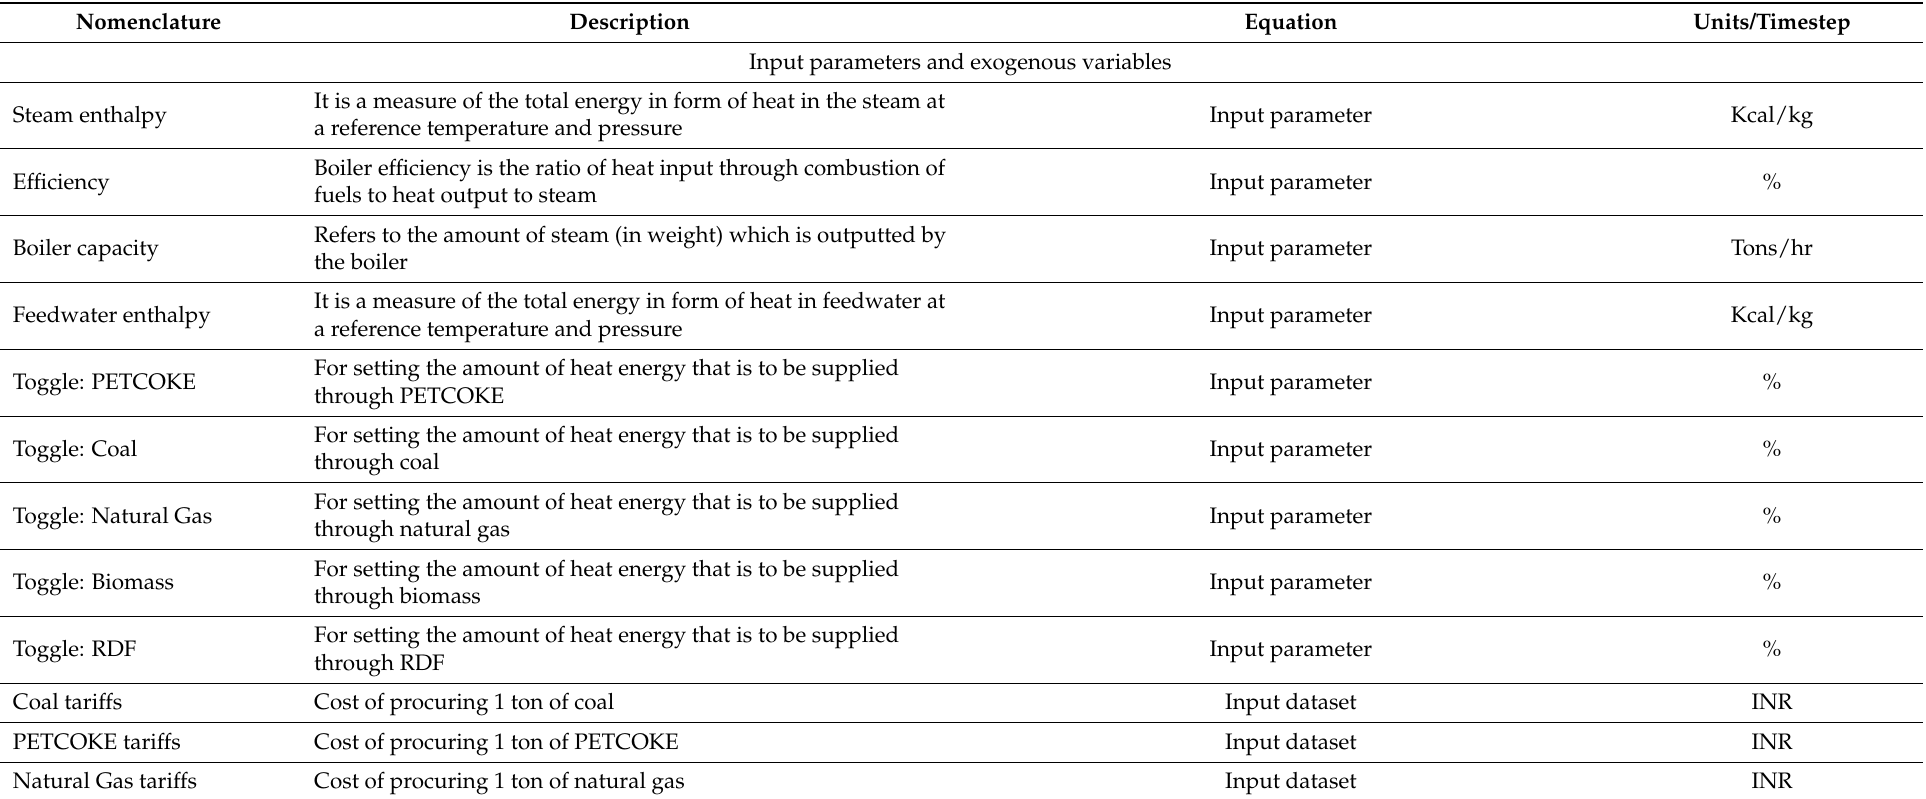
Table A1. Description of the variables used in the proposed